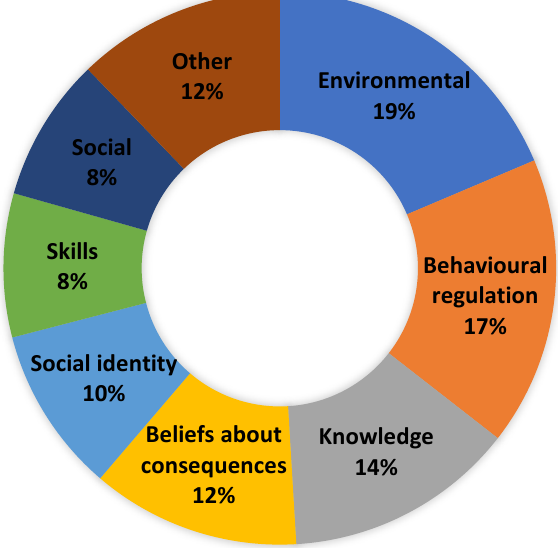
Figure 1. Proportion of total barriers and facilitators by TDF domain .